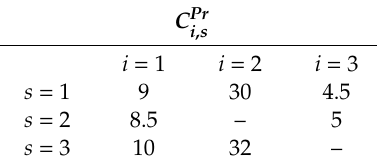
Table A5. Unit purchase cost ( € ).